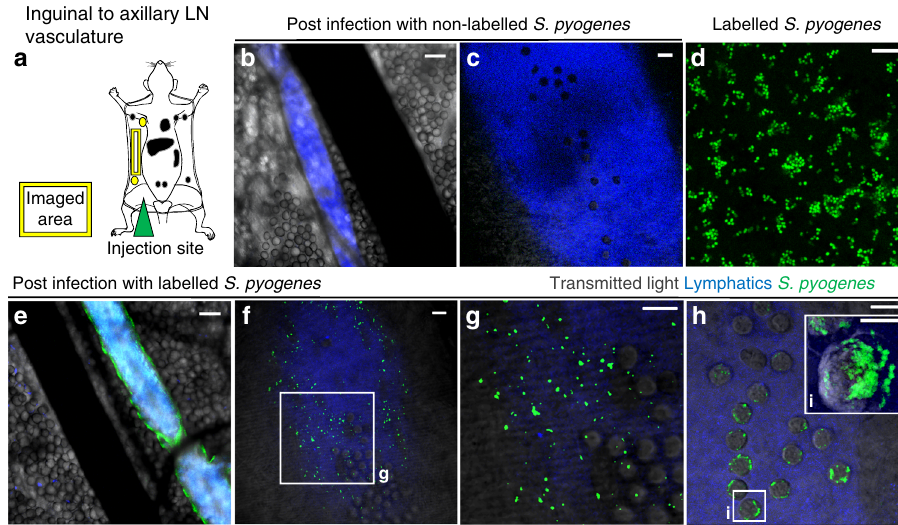
Fig. 2 S. pyogenes transit to and between lymph nodes in lymphatic vessels. a Schematic of imaging area. b – h Intravital microscopy images of the efferent lymphatic vessel that connects the inguinal and axillary lymph nodes in mice. S. pyogenes (green), lymph (blue) and blood vessels (black). FVB/n mice infected intramuscularly with 10 8 CFU of hypervirulent S. pyogenes (H1565), either unlabelled ( b , c ) or fl uorescently labelled ( e – h ) and imaged within 1 h. Scale bars: 100 µ m ( b , e ); 10 µ m ( c , d , f – i ). i Three-dimensional reconstruction of fl uorescently labelled streptococci adhered to leukocyte cell surface, scale bar 5 µ m. Data are representative of four independent experiments. See also Supplementary Fig. 3 and Supplementary Movies 1 – 5.